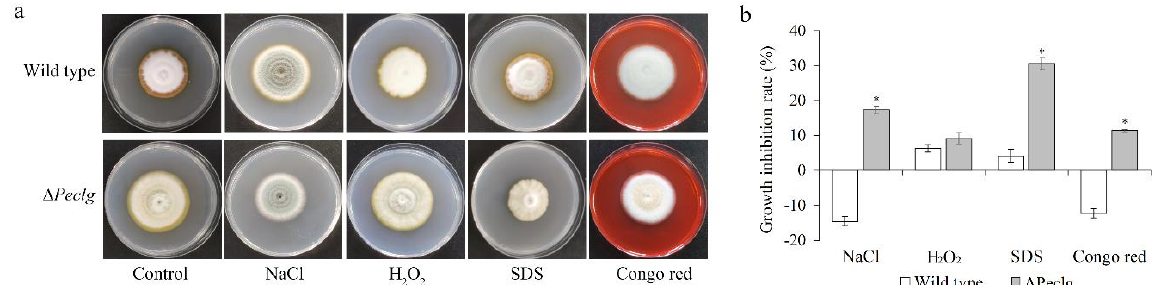
Figure 4. The Peclg gene regulates chemical stress responses in Penicillium expansum . ( a ) Colony morphology of the wild-type and ∆ Peclg strains grown on PDA plate containing 1 M NaCl, 10 mM H 2 O 2 , 0.04% SDS, and 300 μg/mL Congo red. ( b ) Inhibition rate of growth in different stress treatments. The experiments were performed with three biological replicates. Data are presented as means ± SD of three replicates. Asterisks indicate statistically significant differences ( p < 0.05) between strains.